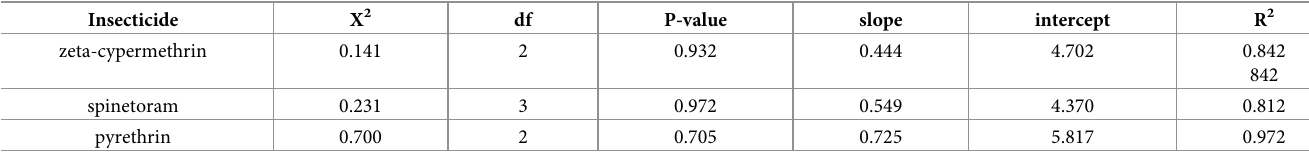
Table 1. Statistics for the initial dose-response probit analysis for each insecticide. Insecticide X 2 df P-value slope zeta-cypermethrin